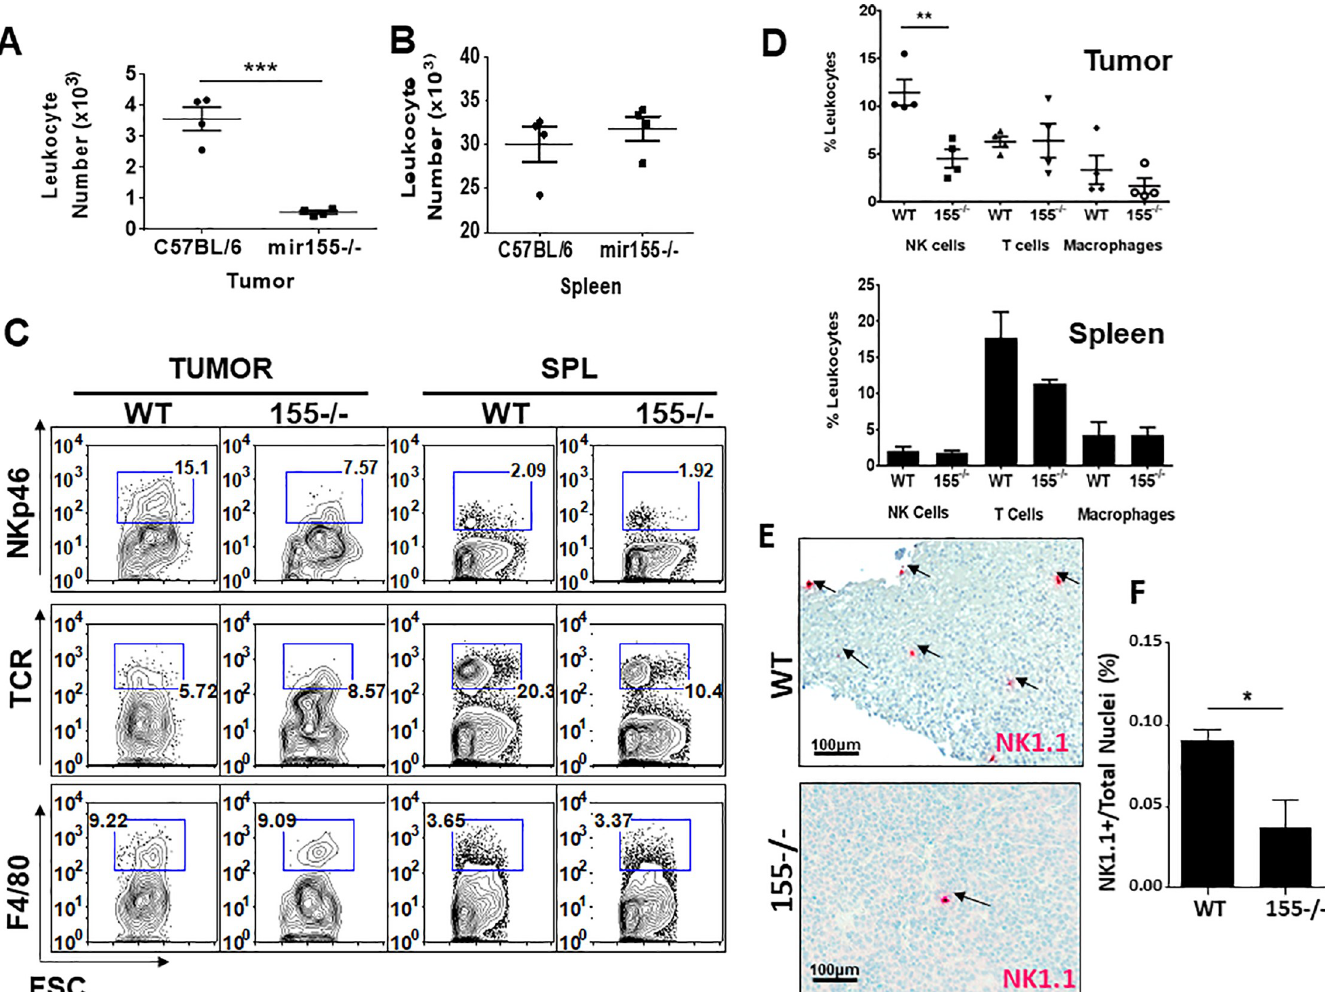
Fig 4. NK cells fail to traffic to AT3 tumors in miR-155 -/- hosts. AT3 tumor cells were injected subcutaneously into WT and miR-155 -/- mice. Four weeks after AT3 tumor implantation, tumors and spleens were collected and homogenized to single cell suspension for analysis of TILs. Data shown is representative of three experiments. Percentage of NK cells in the tumor A) or spleen B) of tumor bearing mice averaged from 3 experiments. C, D) Representative flow cytometric contour plots and graphs of a single experiment (pooled from 3 mice per strain) showing NKp46+ NK cells in tumor and spleen, as well as TCR+ T cells and F4/80 + Macrophage. E) AT3 tumors from WT or miR-155 -/- hosts were fixed, paraffin-embedded and sectioned. The processed tissues were immunostained with anti-NK1.1 to detect intratumoral NK cells, and images of the whole tissues were captured with the Aperio scanning microscope. An imaging algorithm was generated to detect the number of NK1.1+ cells in the tumor. Representative areas of AT3 tumors grafted in WT and miR-155-deficient mice and stained with hematoxylin and anti-NK1.1. Magnification = 200x; Scale bar = 50 um. F) The percentage of NK1.1+ cells in tumors of WT and miR-155-deficient hosts as determined by an imaging algorithm from 2 tumors per strain. The data shown report the mean percentage of NK1.1+ cells of the total nuclei count (as determined by hematoxylin stain) of each entire tumor section. � P < 0.05, �� P < 0.01, ��� P < 0.005.